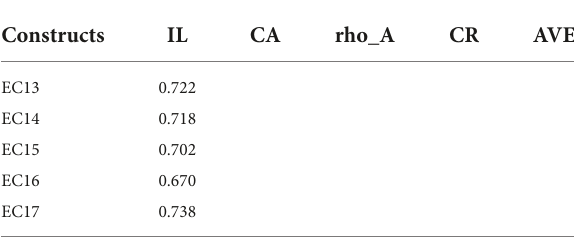
TABLE 1 Reliability and convergent